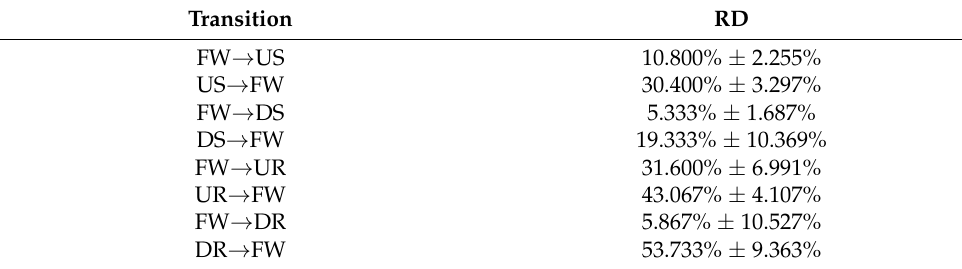
Table 6. DRs of locomotion mode transitions.